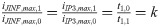
The wave front is initiated in the ER and its speed is determined by the gap junctional coupling d.(A) Time is fixed (t = 335) and we represent the wave from the center to the boundary of the graph. Blue and orange traces, represent ccyt and cER, respectively. (B) The parameters are set such that iJINF,max,1iJINF,max,0=iIP3,max,1iIP3,max,0=t1,0t1,1=k. The oscillation period decreases with large values of iJINF,max,0 and iIP3,max,0. (C-D) The speed of the wave is estimated from simulations by computing the time needed for a circular wave to reach the boundary of the graph, when starting from the center. Error bars represent 95% confidence intervals of the mean. In (C) a positive correlation with the gap junctional coupling is found for any value of iJINF,max,0. We fix iJINF,max,0 = 1.8. In (D), only high values of iJINF,max,0 lead to a negative contribution of the parameter k to the speed. We fix d = 0.003.